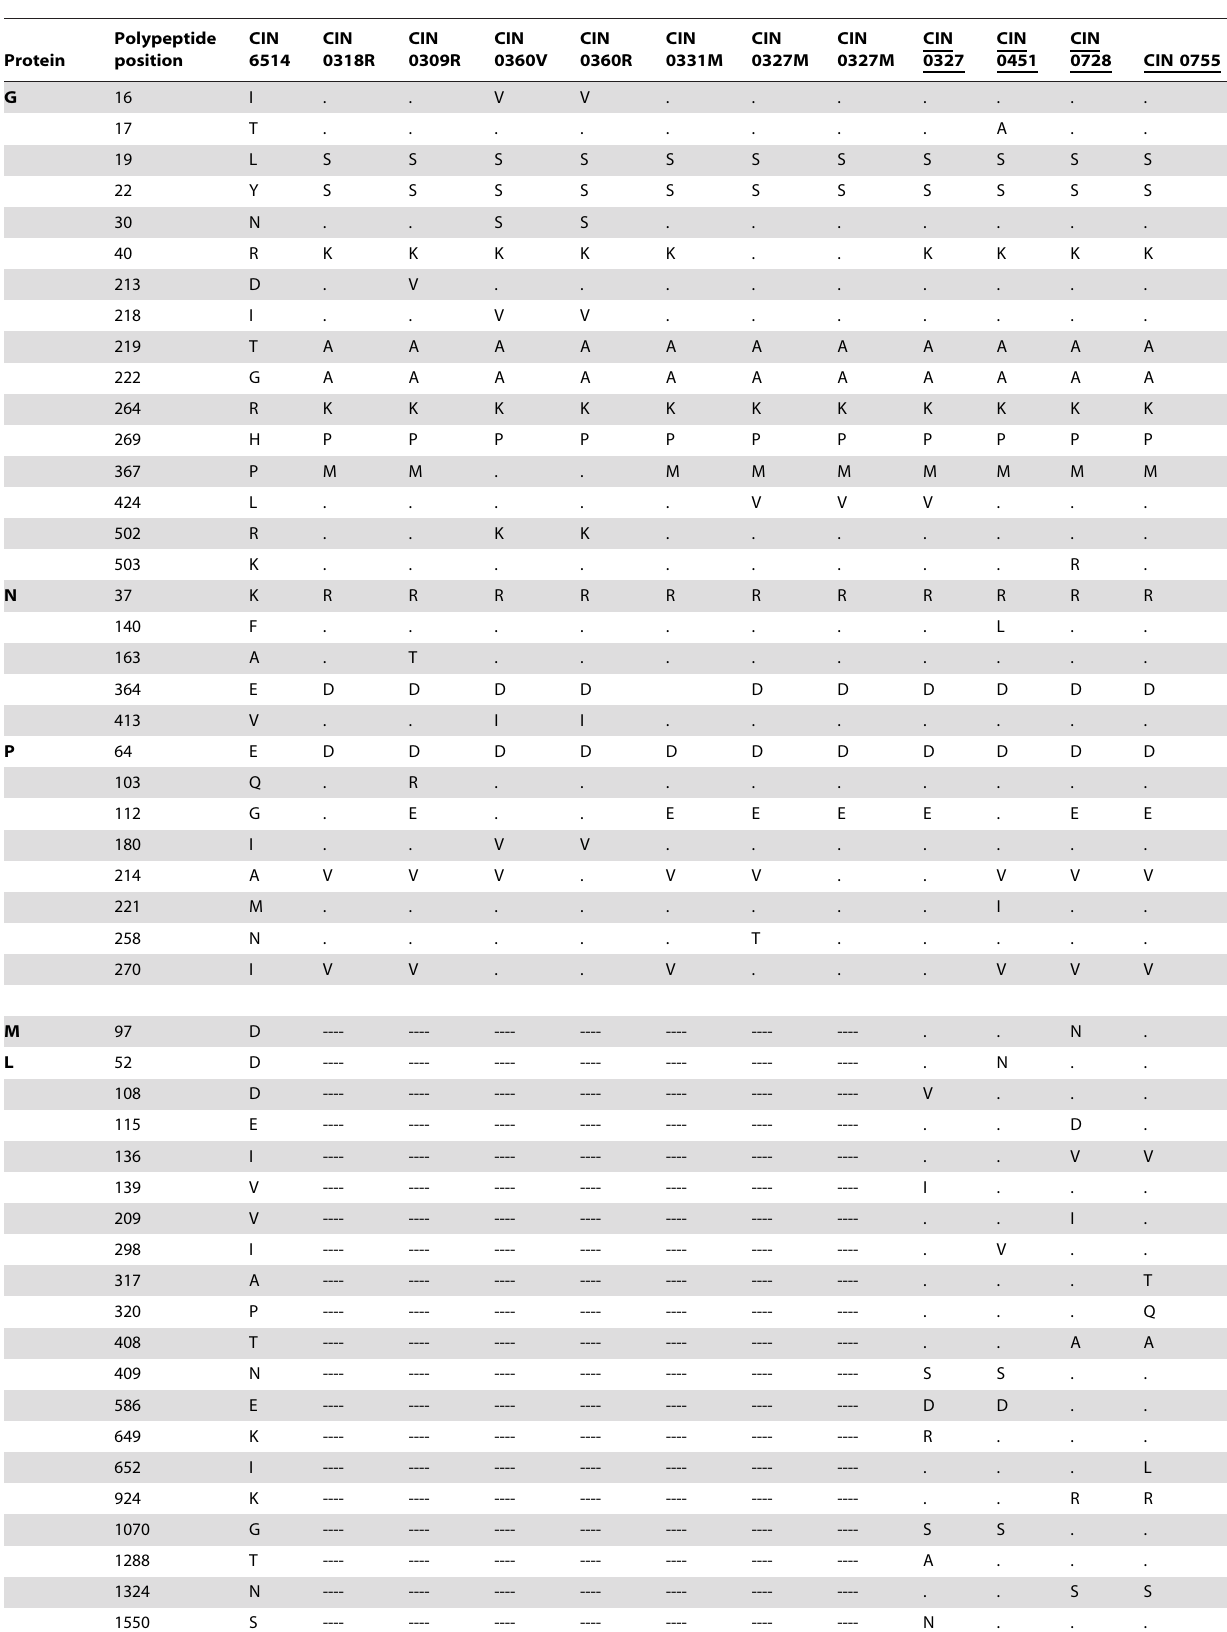
Table 1. Amino acid substitutions observed in the CHPV isolates with respect to the prototype strain CIN6514.